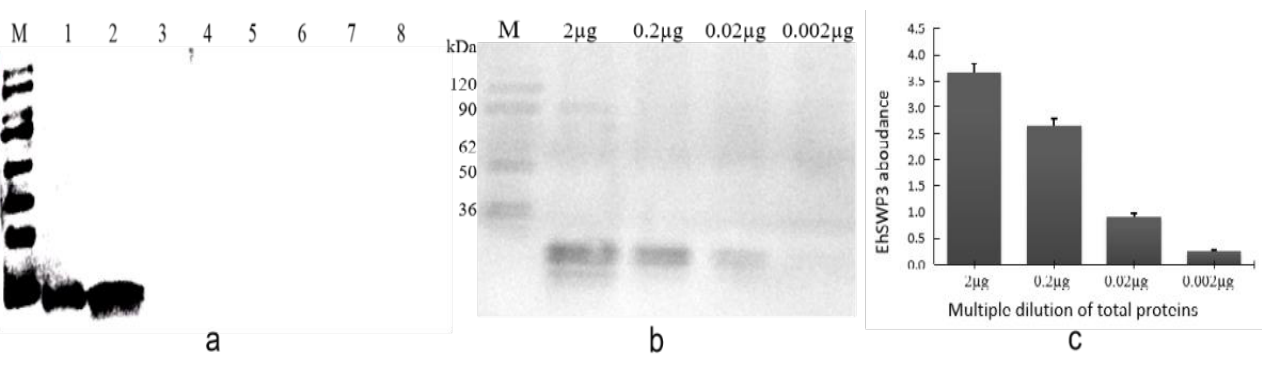
Figure 10. Specificity and sensitivity analysis of PAbs anti-EhSWP3. ( a ) Specificity analysis of PAbs anti-EhSWP3. M: protein marker, lane 1: proteins extracted from EHP spores, lane 2: proteins extracted from the hepatopancreas of EHP-infected shrimps, lanes 3–8: protein from the controls ( H. eriocheir , A. portunus , N. bombycis , V. ceranae , P. pastoris, and S. aureus, respectively). ( b ) Sensitivity analysis of PAbs anti-EhSWP3. M: protein molecular weight marker. Here, 10 µL gradient dilution solution of total proteins extracted from shrimp hepatopancreases was loaded for each lane (lane 1: 2 µg, lane 2: 0.2 µg, lane 3: 0.02 µg, lane 4: 0.002 µg). ( c ) Gray analysis of Figure 10b.